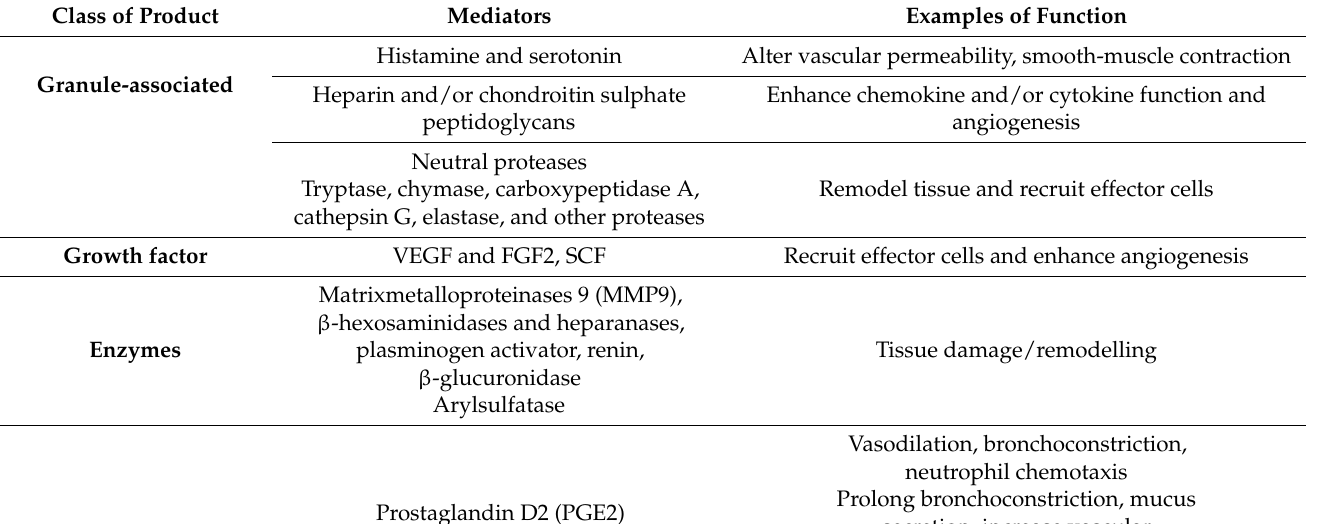
Table 5. Mediators of